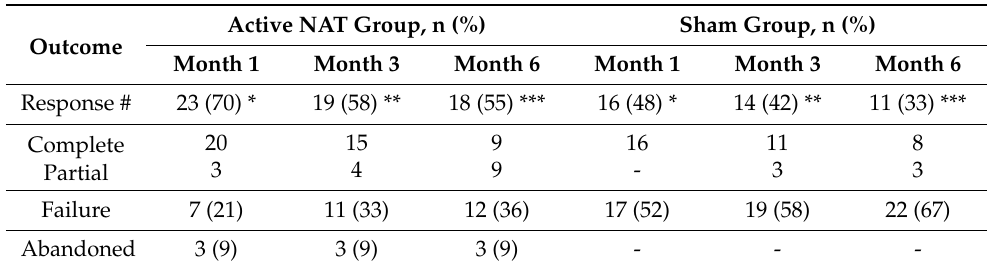
Table 2. Outcomes for each treatment group at all study follow-up visits, ITT population. Patients responding, treatment failures, and patients who abandoned the study are specified. Active NAT Group, n (%) Sham Group, n (%) Outcome Month 1 Month 3 Month 6 Month 1 Month 3 Month 6 Response